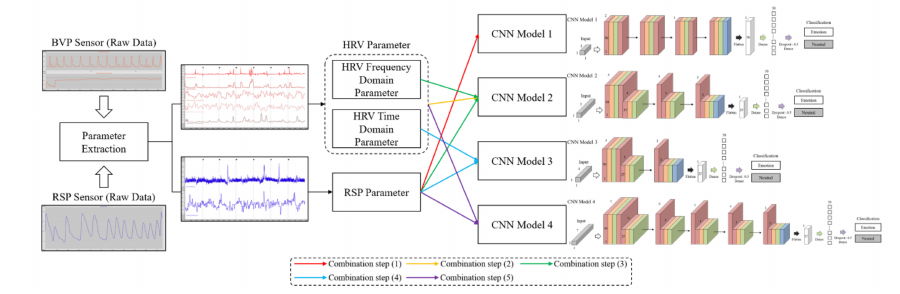
Figure 9. The pipeline of the overall